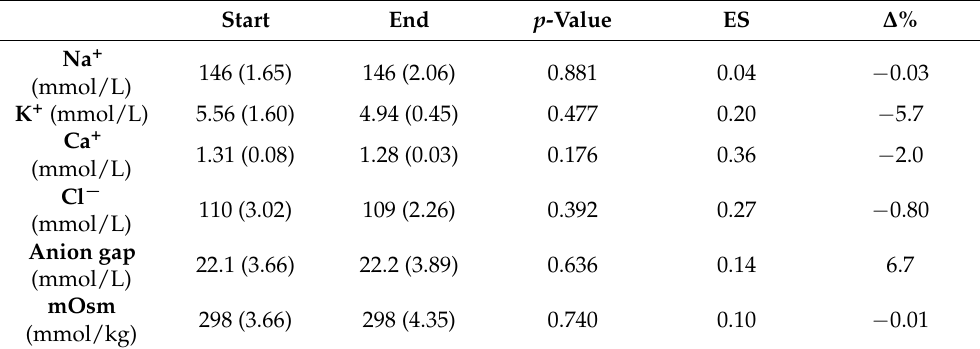
Values are mean (SD). Anion gap = difference between anions and cations in plasma and mOsm = plasma